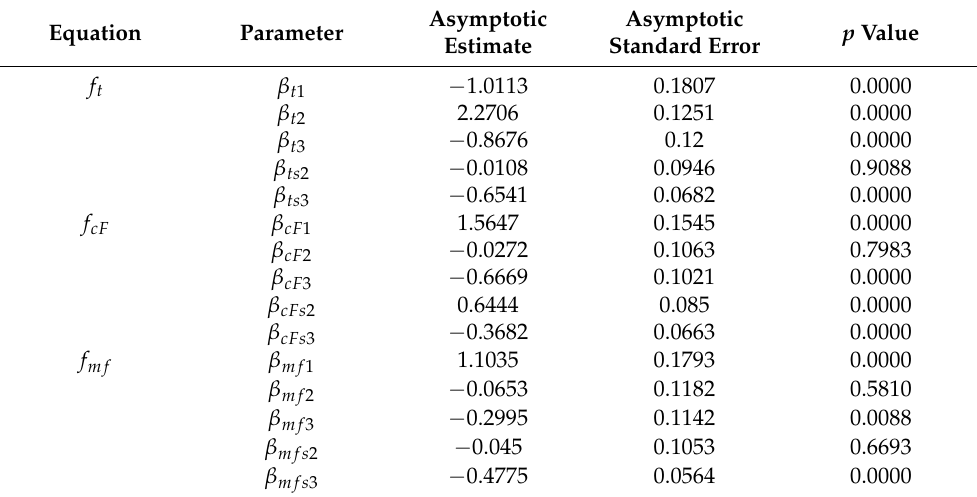
Table 6. Parameter estimates and their asymptotic standard error and p values for the disaggregated root biomass equation system.